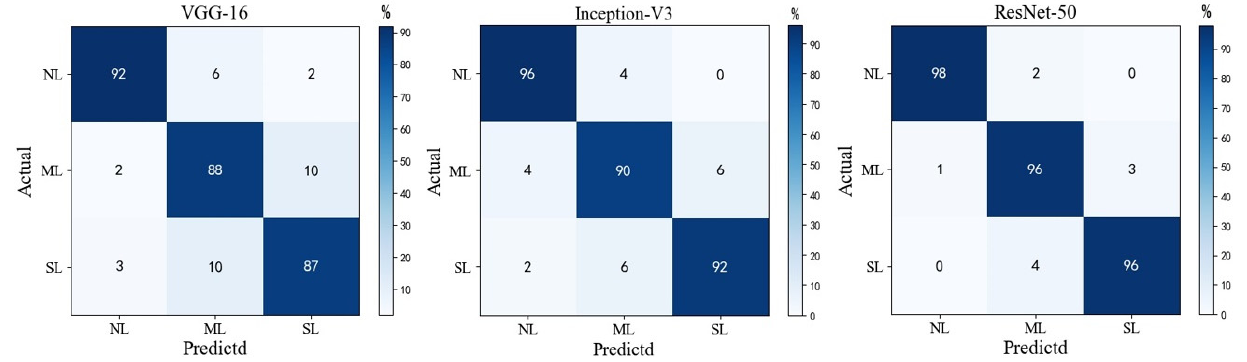
lodging, ML is moderate lodging, SL is severe lodging.